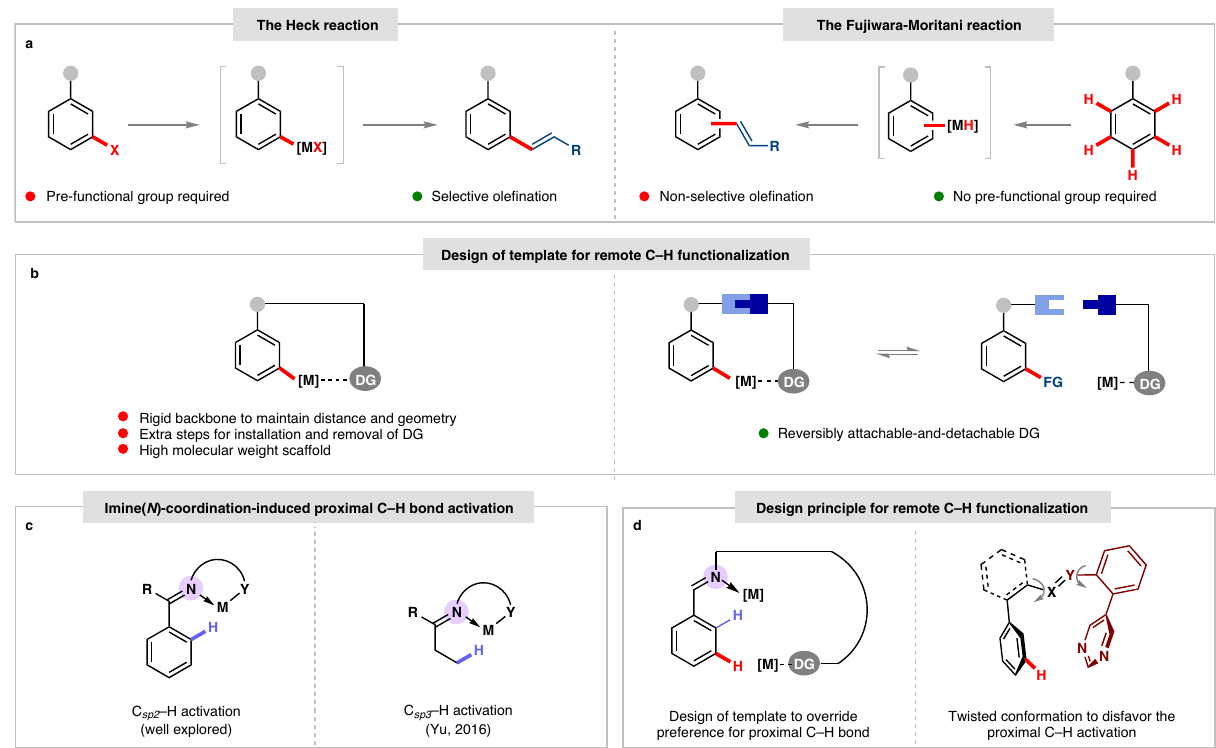
Fig. 1 Temporary directing group (TDG) assisted remote C – H functionalization. a The Heck reaction vs The Fujiwara-Moritani reaction. b Covalent template directed remote C – H functionalization vs TDG; X = Y, imine; M, Metal; DG, Directing Group; FG, Functional Group. c TDG-assisted ortho -C – H